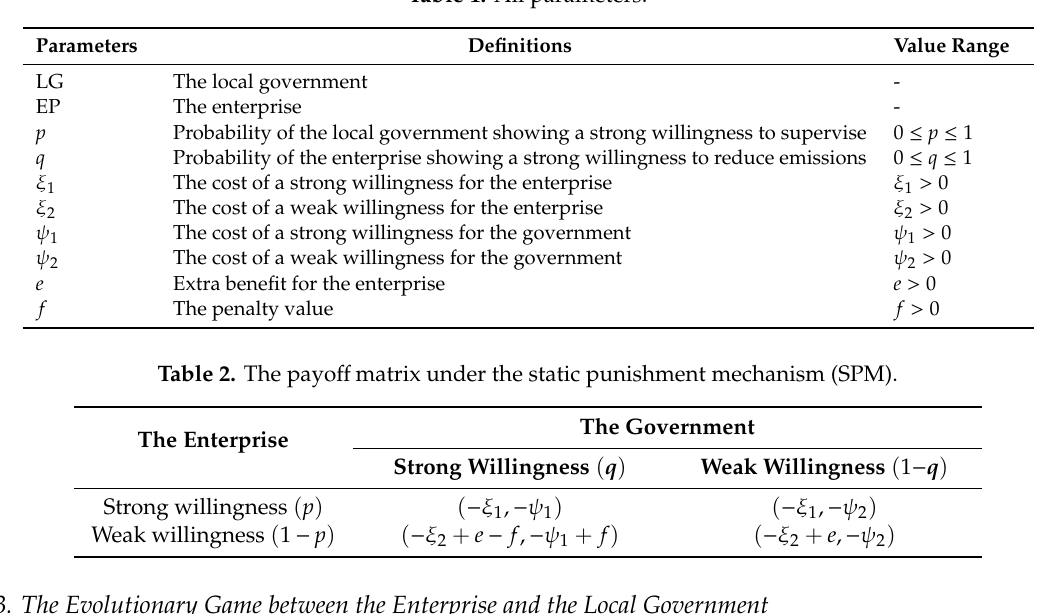
Table 1. All parameters.